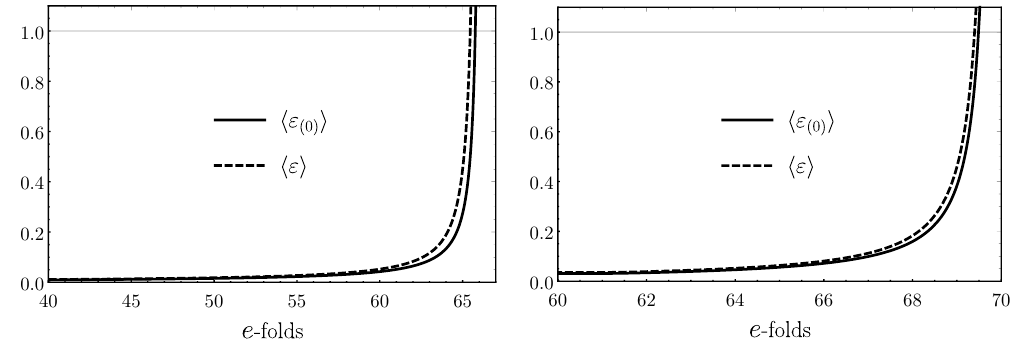
Figure 4 . Evolution of " for set 1 (left) and set 2 (right). The quantity h " slow roll parameter averaged over oscillations in the potential and without the contribution due to the backreaction on the K(cid:127)ahler moduli, while h " i is the averaged slow roll parameter taking backreaction into account.